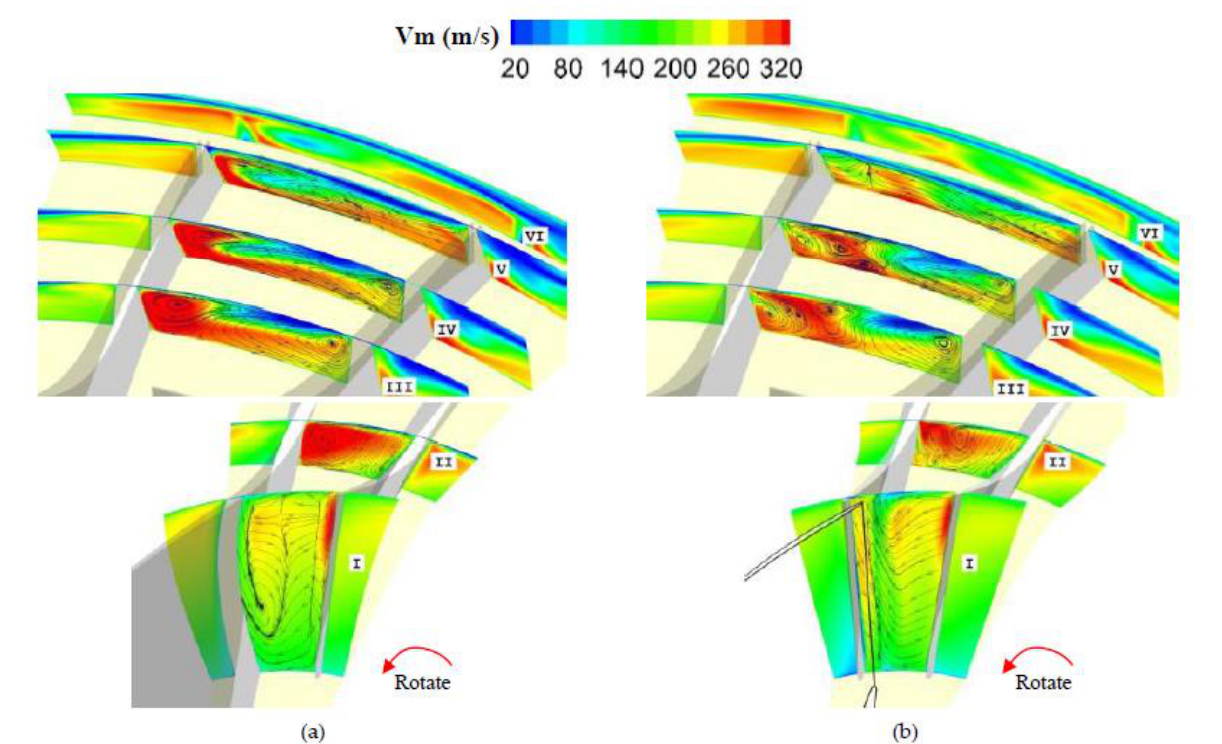
Figure 16. Evolution of the meridional velocity within the conventional and baseline tandem impeller passages ( P.E. point). ( a ) Conventional impeller, and ( b ) baseline tandem impeller.